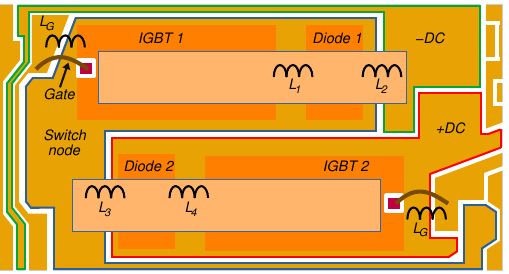
Figure 2. Top view of a DBC sub-assembly with Sinterconnects indicating the main parasitic inductances.